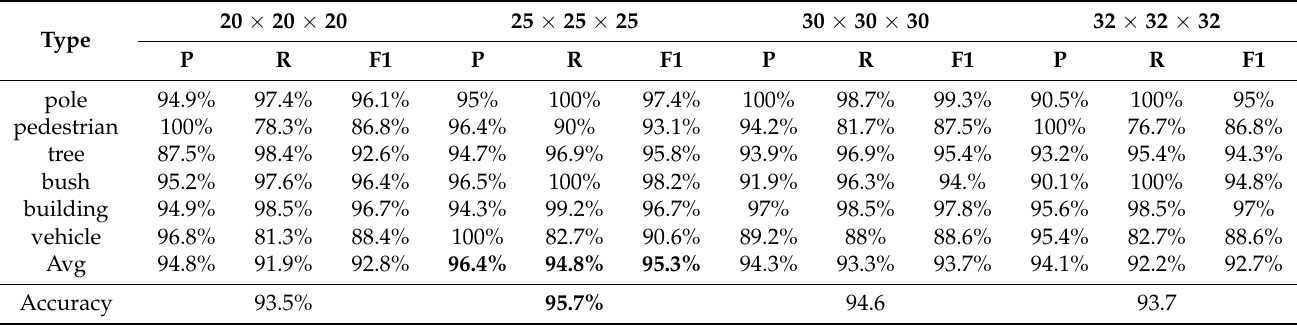
Table 2. Classification performance of the six objects with different resolutions of Hough spaces.